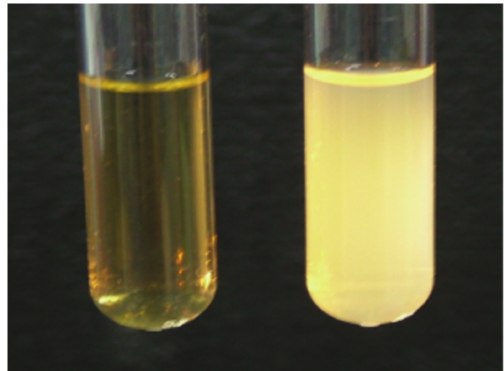
Figure 1: Opacification of human serum by SOF. Human serum was incubated overnight with either bu ff er control (left) or with 1 μ g/ml of recombinant SOF